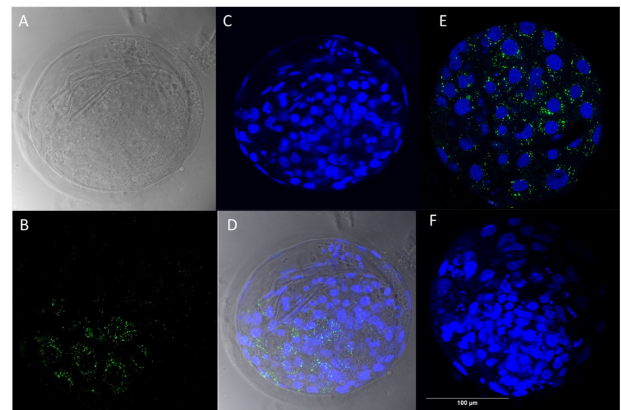
Figure 4. Bright field and fluorescence images demonstrating the passage of EVs through the zona pellucida and the subsequent EVs uptake by the cells of the blastocyst. EVs isolated from concentrated conditioned medium were pre-labeled with green fluorescent PKH67 dye, followed by 0.22 µ M filtration) and ultimately co-incubated with 7 dpi bovine embryos in ultracentrifuged SOF+ITS+BSA medium. After co-incubation of ( A ) zona-intact bovine embryos with ( B ) PKH67-labeled EV’s, embryos were washed, fixed, and stained with ( C ) Hoechst 33342 to visualize the nuclei. The ( D ) overlay image demonstrates uptake of green fluorescent-labeled EVs by zona-intact embryos during in vitro embryo culture. ( E ) PKH67-labeled follicular fluid derived EVs (positive control) were also uptaken by bovine embryos in culture. ( F ) PKH67-labeled PBS co-incubated with bovine embryos did not show any green fluorescence (negative